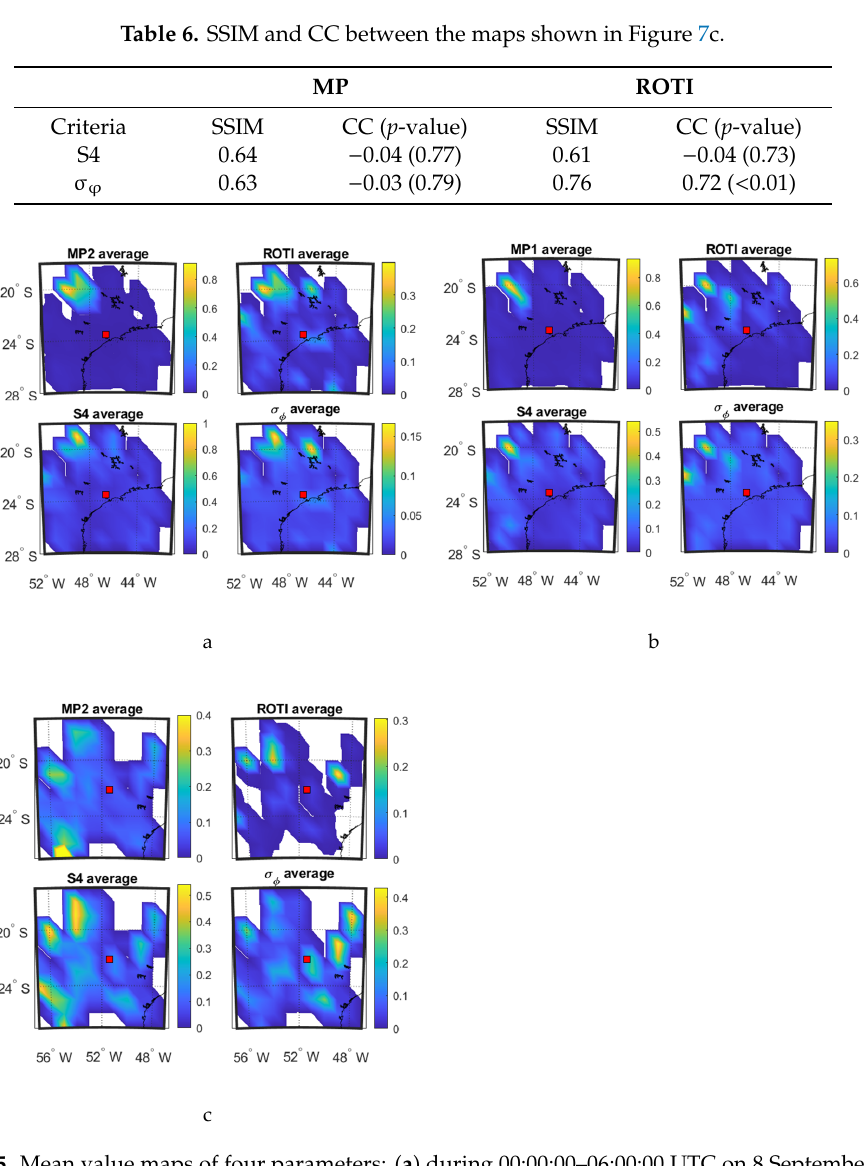
Figure 5. xxxxxxxxxxx Figure 5. Mean value maps of four parameters: ( a ) during 00:00:00–06:00:00 UTC on 8 September